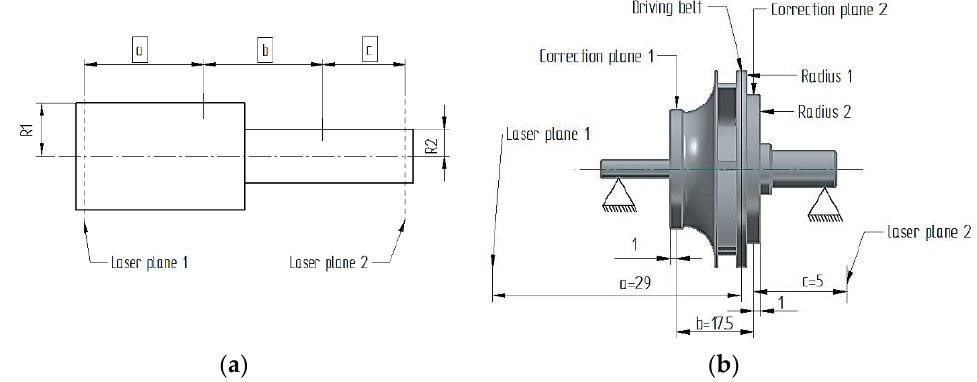
Figure 14. Positioning of the closed impeller on the balancing machine: ( a ) correction plane posi- tioning with corresponding radii; ( b ) closed impeller and shaft mounted on balancing machine.